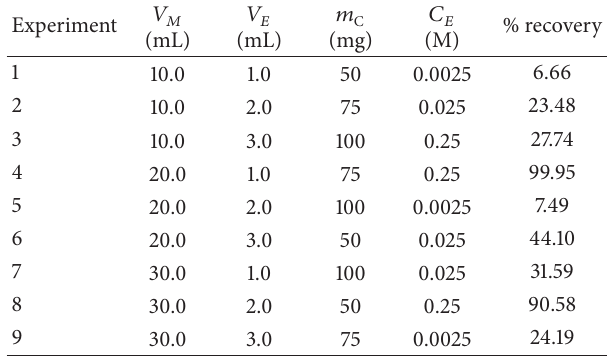
Table 4: Matrix obtained during optimization design for the MSPE